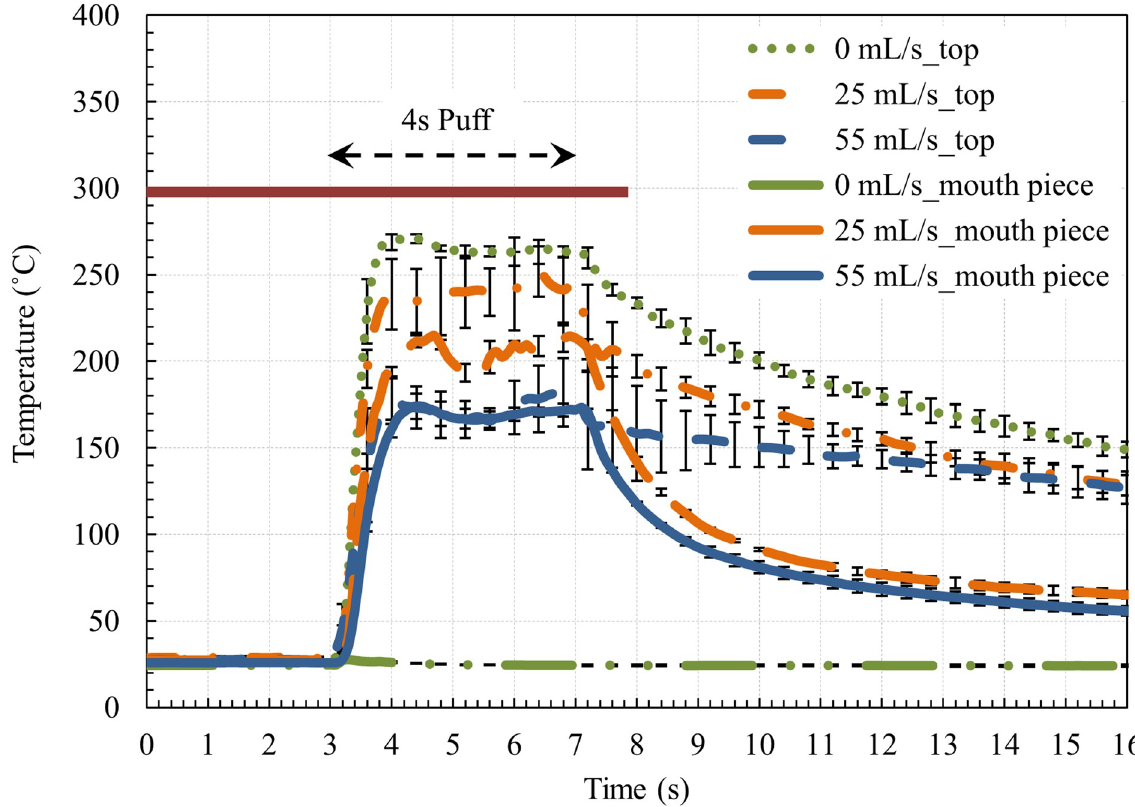
Fig 4. Aerosol temperature at the top section of atomizer and at the mouth piece of the e-cigarette. Dot green line: temperature at the top section of the atomizer for the air flow rate of 0 mL/s, dash dot orange line: temperature at the top section of the atomizer for the air flow rate of 25 mL/s, dash blue line: temperature at the top section of the atomizer for the air flow rate of 55 mL/s, long dash dot dot green line: temperature at the center of the mouth piece for the air flow rate of 0 mL/s, long dash orange line: temperature at the center of the mouthpiece for the air flow rate of 25 mL/s, solid blue line: temperature at the center of the mouthpiece for the air flow rate of 55 mL/s.